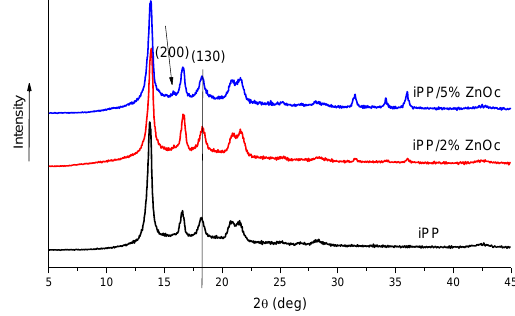
Figure 5. WAXD spectrum of iPP and iPP/ZnOc composites.